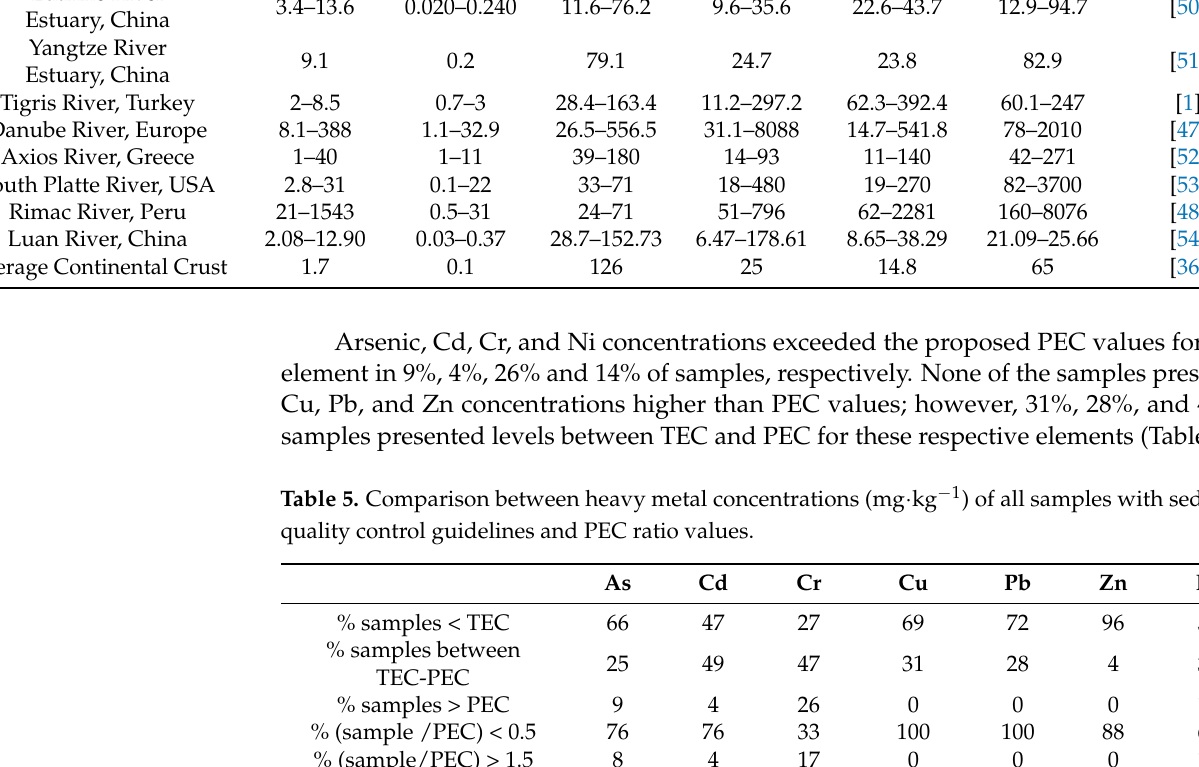
Table 4. Heavy metal concentrations in sediment samples from other locations worldwide and average crust (mg · kg − 1) . Location As Cd Cr